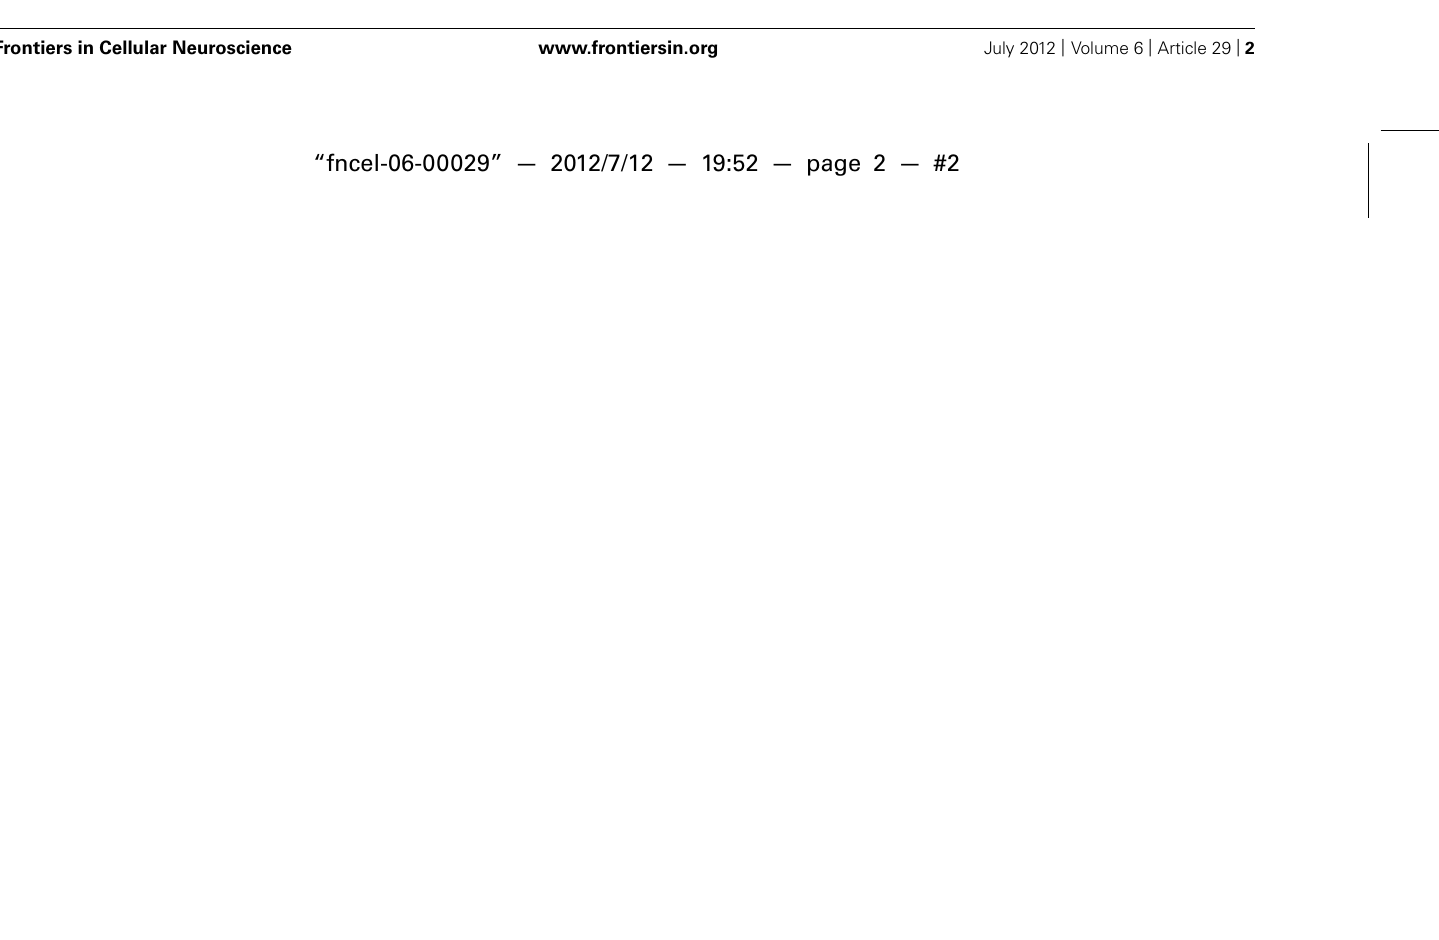
FIGURE 1 | Olfactory coding and disruption of insect behavior through OR modulation. (A) Two models of receptor codes for odorants. In the concept of combinatorial coding , a general odorant (e.g., Odorant 2) is detected by a unique set of generalist ORs (ORa-Orco and ORb-Orco), while a pheromone is specifically recognized by a specialist OR (ORc-Orco). Broad-tuning results from promiscuous orthosteric sites on ORs.The specialist coding model assumes that adaptive evolution shapes orthosteric sites to specifically recognize low concentrations of semiochemicals (Sem.),